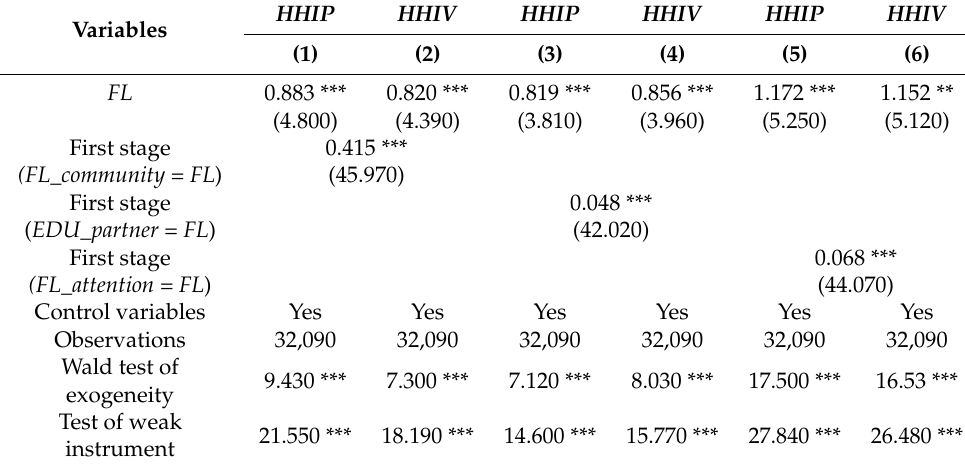
Table 8. Endogeneity problem